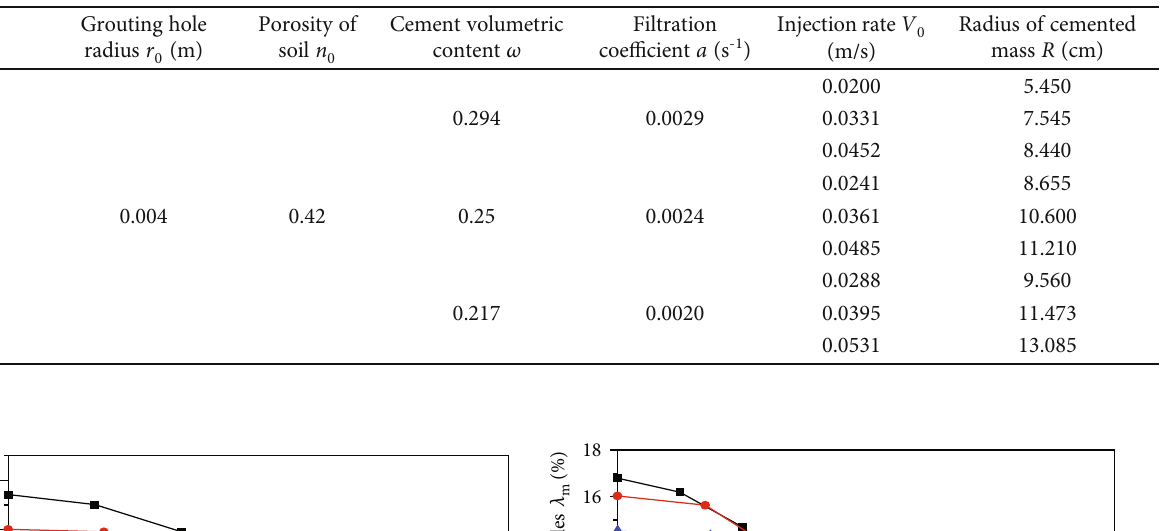
Table 2: Grouting test results under each working condition.